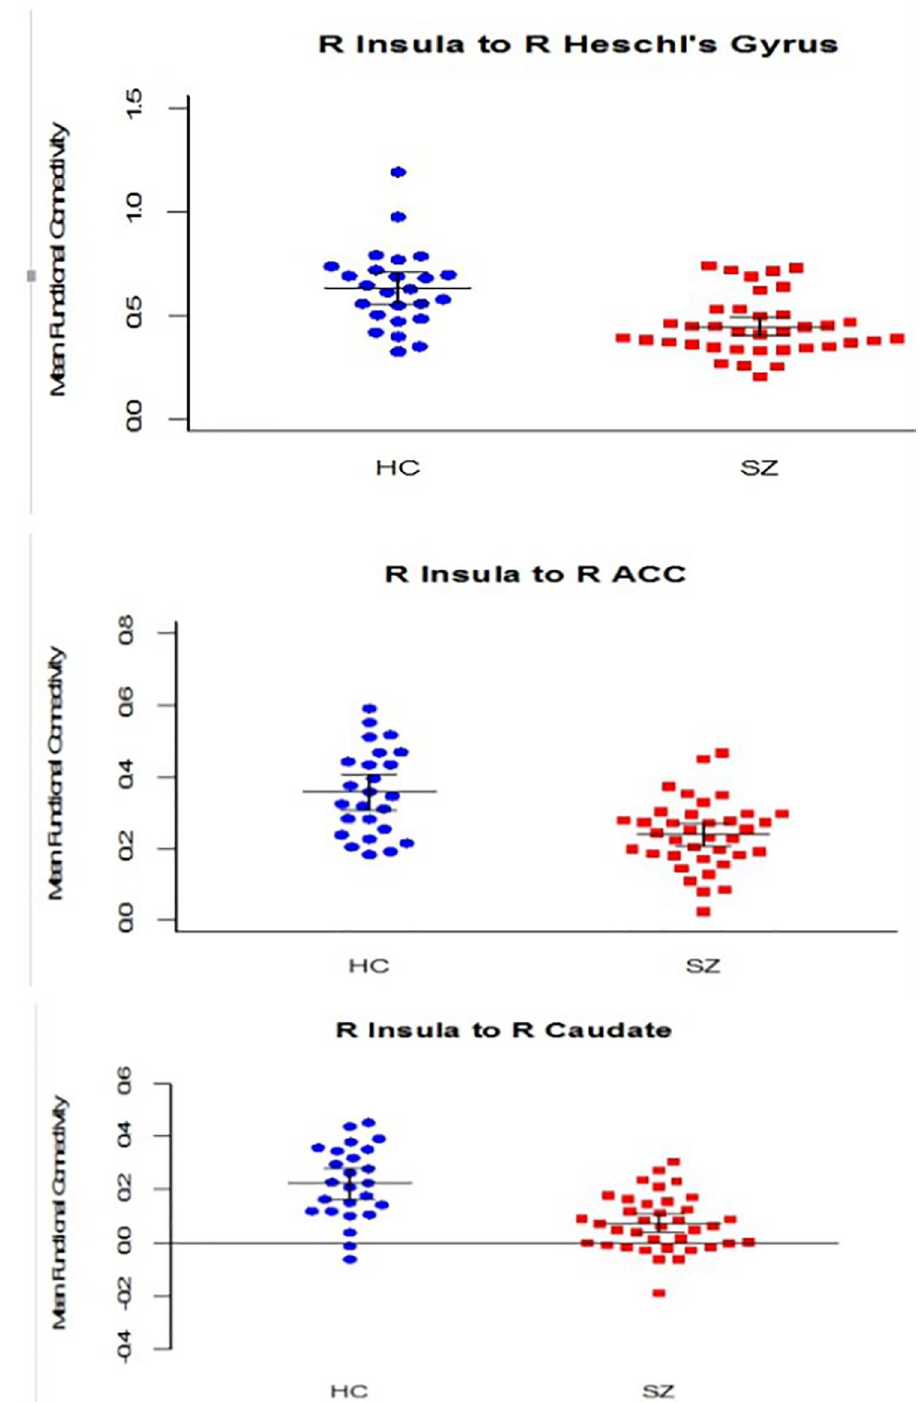
Fig 1. ROI based analysis: group comparisons in the right hemisphere. Note: Regionsof right insula connectivity with significantgroup difference (p < 0.001, with Bonferroni corrections): right anterior cingulate, right Heschl’sgyrus and right caudate. The horizontallines representmeans and the error bars represent 95% confidenceintervals.